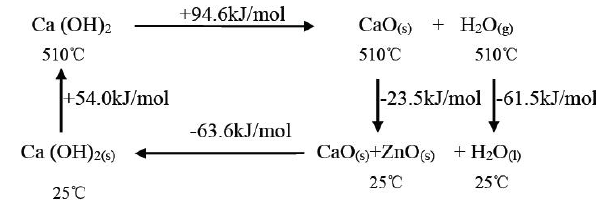
Figure 7: Dehydration/hydration cycle for Ca(OH) 2 /CaO ergy [13]. When the stored high temperature steam at 510 ∘ is used in the hydration step, 125.1 kJ could be recovered, i.e., 84.2% of the initial input of energy. In comparison, the decomposition of Ca 2− α Zn α (OH) 4 into CaO+H 2 O and ZnO+H 2 O exhibits a higher re- covery of the stored heat energy. Fig. 8 displays the cycle for the thermal storage using the reaction Ca 0.8555 Zn 1.1445 (OH) 4 → CaO+ZnO+H 2 O per gram of com- posite. The decomposition energy of 764.5 J/g is obtained from the DSC test for Ca 0.8555 Zn 1.1445 (OH) 4 (Fig. 6), while the other thermal parameters are estimated from Fig. 7 accordingly.